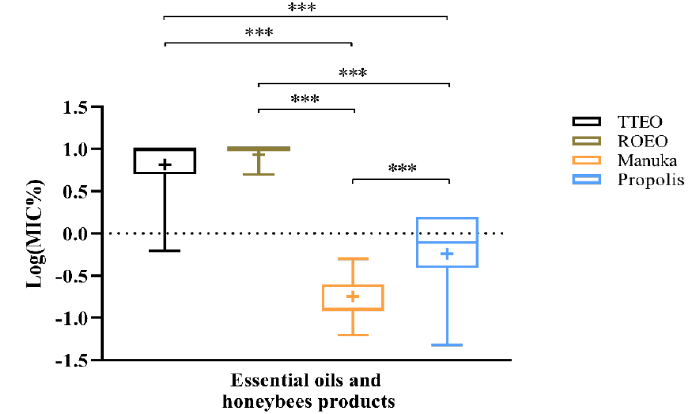
Figure 3. One-way ANOVA and multiple comparison test between MIC for di ff erent natural products. The box and whisker plot refers to the logarithmic transformation of raw data to improve the correlation of data with di ff erent magnitude. Data are presented as min to max, the horizontal line (within each plot) refers to median, while “ + ” indicates mean. (*** p -value < 0.001). Each of the EOs were statistically different from both manuka and propolis ( p-value < 0.0001),